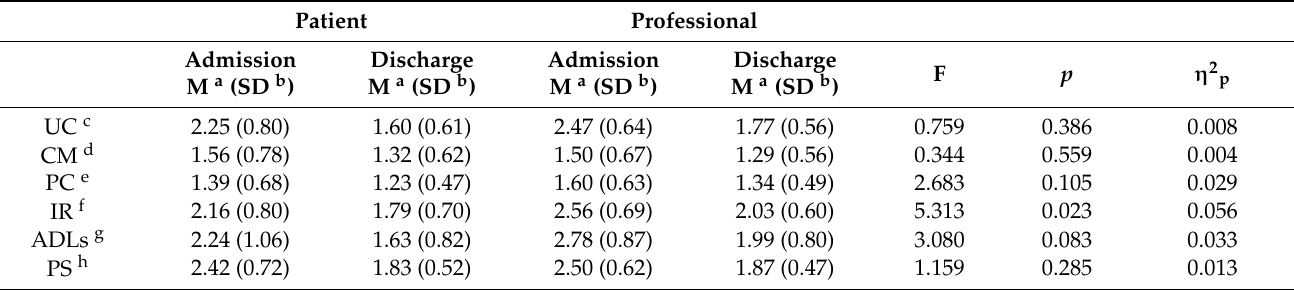
Table 3. Interaction between time and the evaluator in the different factors of the WHODAS.